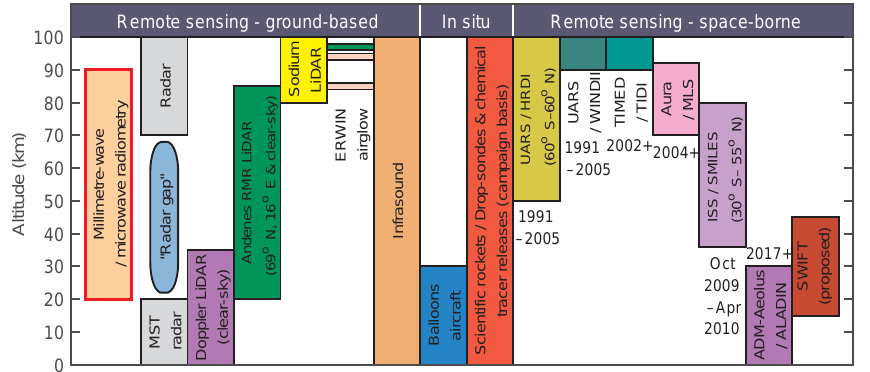
Figure 1. Overview of atmospheric wind measurement techniques with their altitude coverage. For space-borne sensors the abbreviations for the satellite/instrument names are given with years of